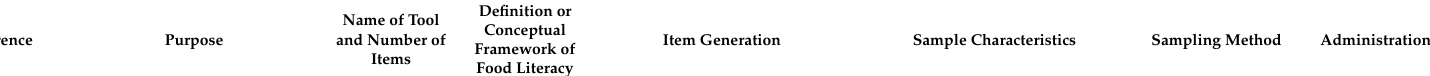
Table 1. A summary of key characteristics and underlying conceptual framework of reviewed food literacy